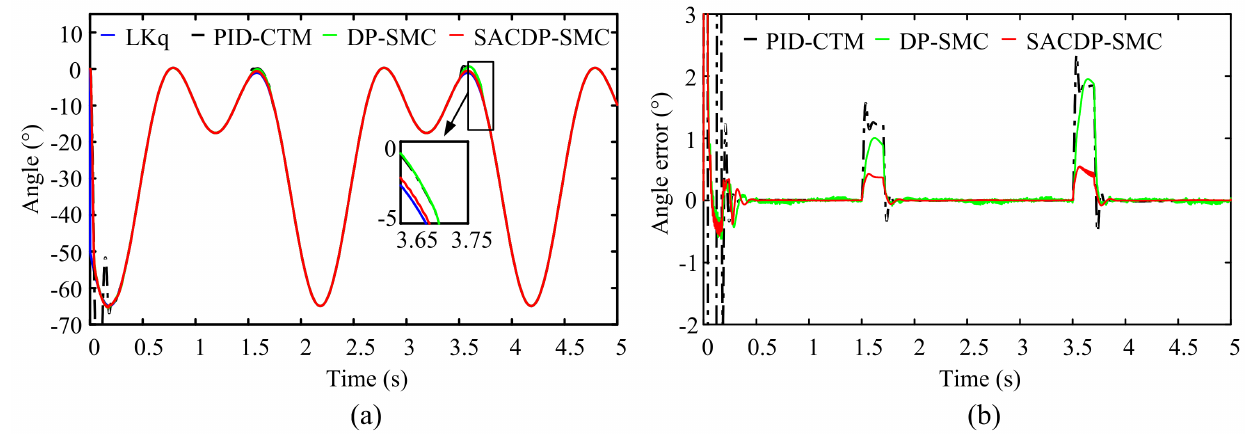
Figure 8. The angle tracking curve and error of the left knee. ( a ) The tracking curve of the left knee; ( b ) The tracking error of the left